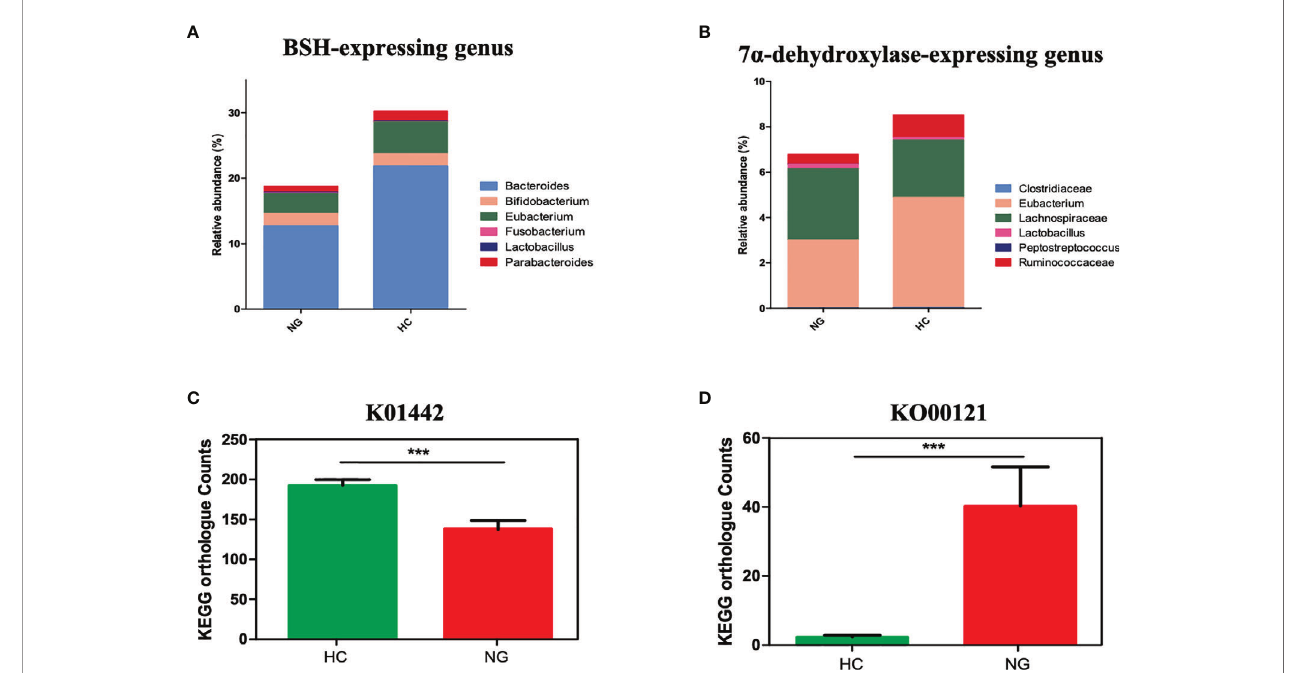
FIGURE 3 | The association between a Eubacterium-depleted microbiota and bile acid biotransformation in children with NAFLD. (A) The relative abundances of bile acid hydrolase (BSH)-active gut bacteria. (B) The relative abundances of 7 a -dehydroxylating gut bacteria. (C) Inference function of BSH KEGG ortholog counts (K01442) (p < 0.001). (D) Inference function of secondary bile acid biosynthesis KEGG ortholog counts (ko00121) (P < 0.001). ***P <